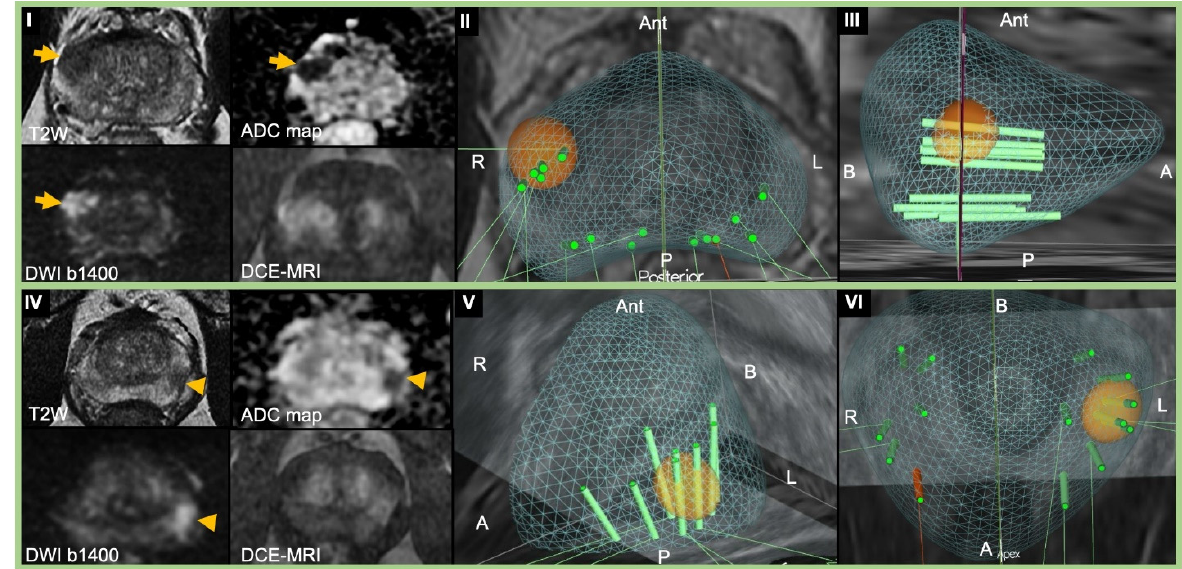
Figure 1. Representative images of 3D-TRUS/MRI fusion-guided transperineal and transrectal prostate biopsy. ( I – III ) A 75-year-old man with PSA 9.48 ng/mL who underwent 3D-TRUS/MRI fusion-guided TP prostate biopsy under local anesthesia with Gleason Grade Group 5 prostatic adenocarcinoma detected on target biopsy without any complications. ( I ) Pre-biopsy multiparametric MRI showing a 1.2 cm PI-RADS 4 lesion (arrow) in the right mid-anterior peripheral zone. The lesion was moderately hypointense on T2W, focal markedly hypointense on the ADC map, markedly hyperintense on high b-value DWI, and showed focal early enhancement on DCE. ( II ) Transverse and ( III ) right sagittal view of 3D-TRUS/MRI fusion-guided TP prostate biopsy (green cores) cartography. Blue mesh is the contour of the prostate. Target (orange sphere) was assigned on right mid-anterior peripheral zone PI-RADS 4. ( IV – VI ) A 62-year-old man with PSA 5.98 ng/mL who underwent 3D-TRUS/MRI fusion-guided TR prostate biopsy under local anesthesia with Gleason Grade Group 3 prostatic adenocarcinoma detected on target biopsy without any complications. ( IV ) Pre-biopsy multiparametric MRI showing 0.9 cm PI-RADS 4 lesion (arrowhead) in the left mid posterior peripheral zone. The round-shaped lesion was moderately hypointense on T2W, focal markedly hypointense on the ADC map, markedly hyperintense on high b-value DWI, and showed focal early enhancement on DCE. The segmentation is the same as TP biopsy. ( V ) Left sagittal view and ( VI ) coronal view of 3D-TRUS/MRI fusion-guided TR prostate biopsy (green cores) cartography. Target was assigned on left posterior apex peripheral zone. T2W, T2 weighted; ADC, apparent diffusion coefficient; DWI, diffusion-weighted imaging; DCE, dynamic contrast-enhanced; A, apex; B, base; R, right; L, left; Ant, anterior; P, posterior; PSA, prostate-specific antigen; MRI, magnetic resonance image; PI-RADS, Prostate Imaging Reporting and Data System; 3D, three-dimension; TRUS, transrectal ultrasound; TP, transperineal; TR, transrectal.